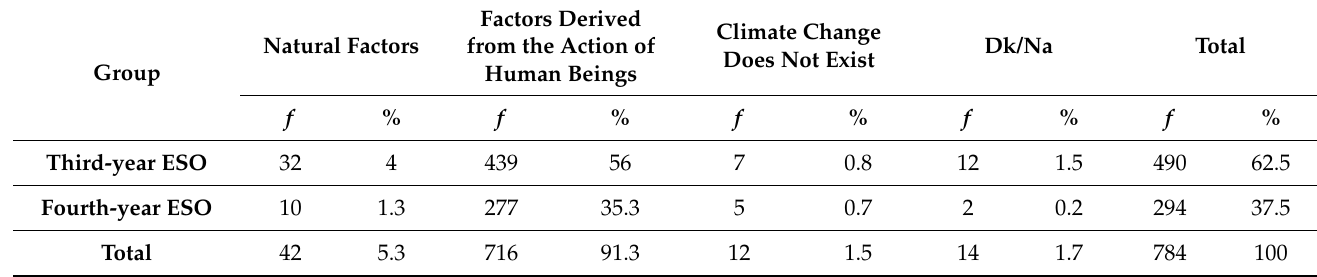
Table 6. Response options regarding factors that influence climate change by school year